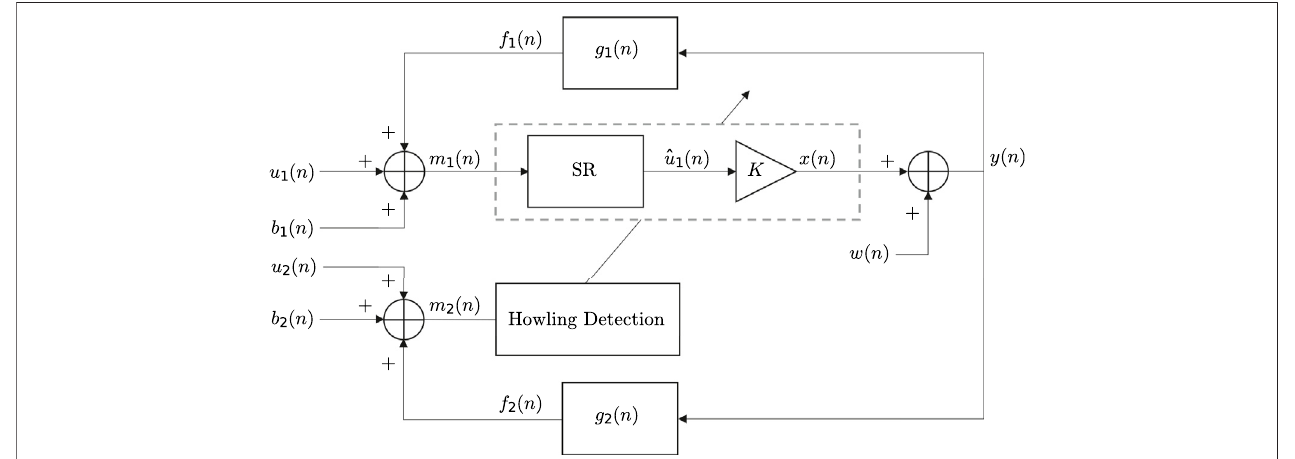
FIGURE 1 | Proposed speech reinforcement system, controlled by the howling-detection